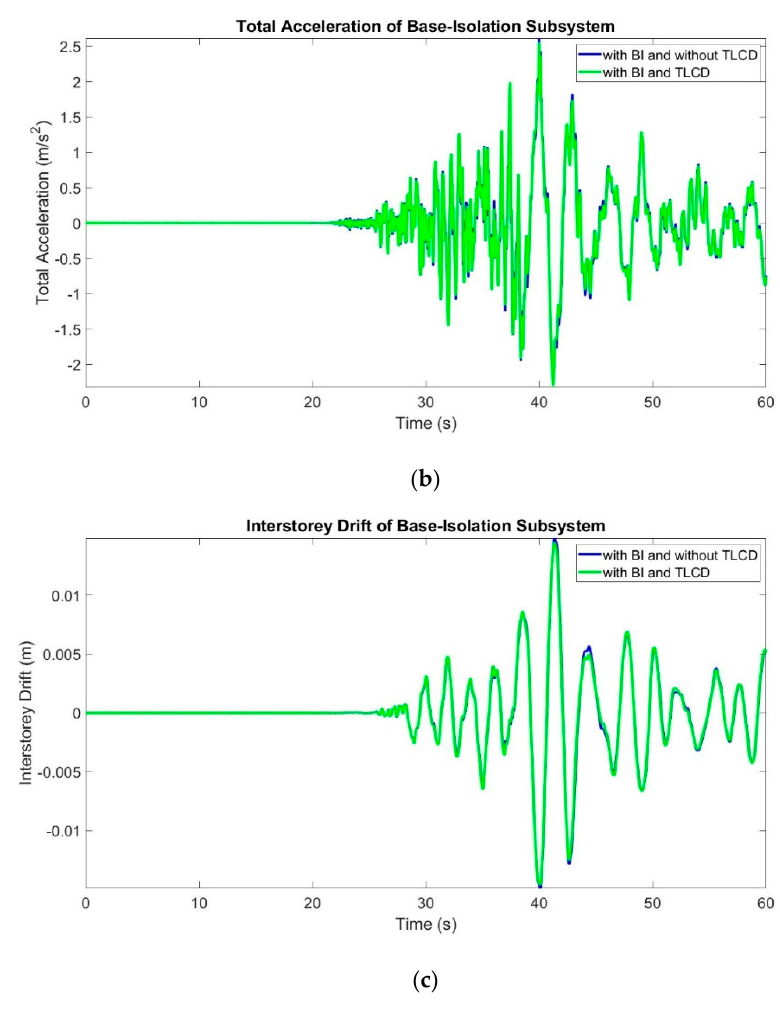
Figure 7. Response time histories of the base level for the earthquake-prone simple uncontrolled structure, base-isolated structure, and hybrid-controlled structure no. 37 record: ( a ) displacement; ( b ) total acceleration; ( c ) interstory drift.